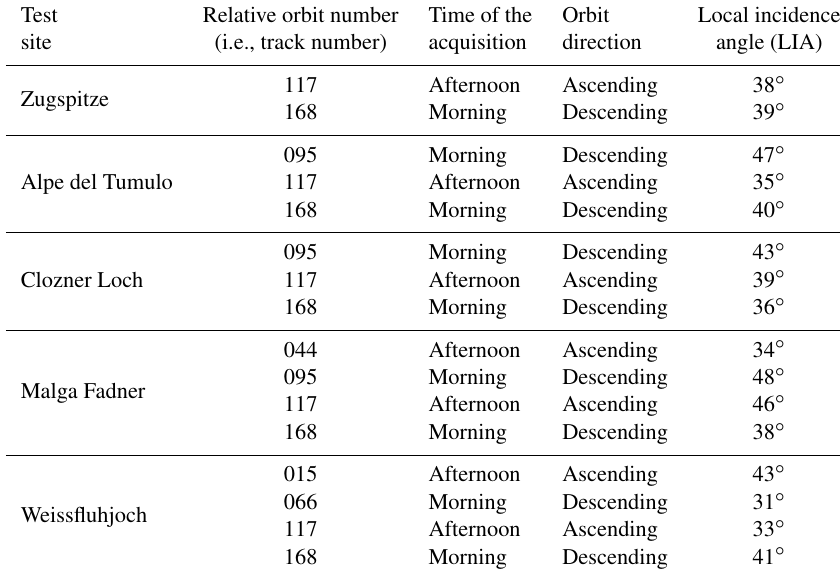
Table 4. List of the Sentinel-1 acquisitions and their main characteristics over the five test